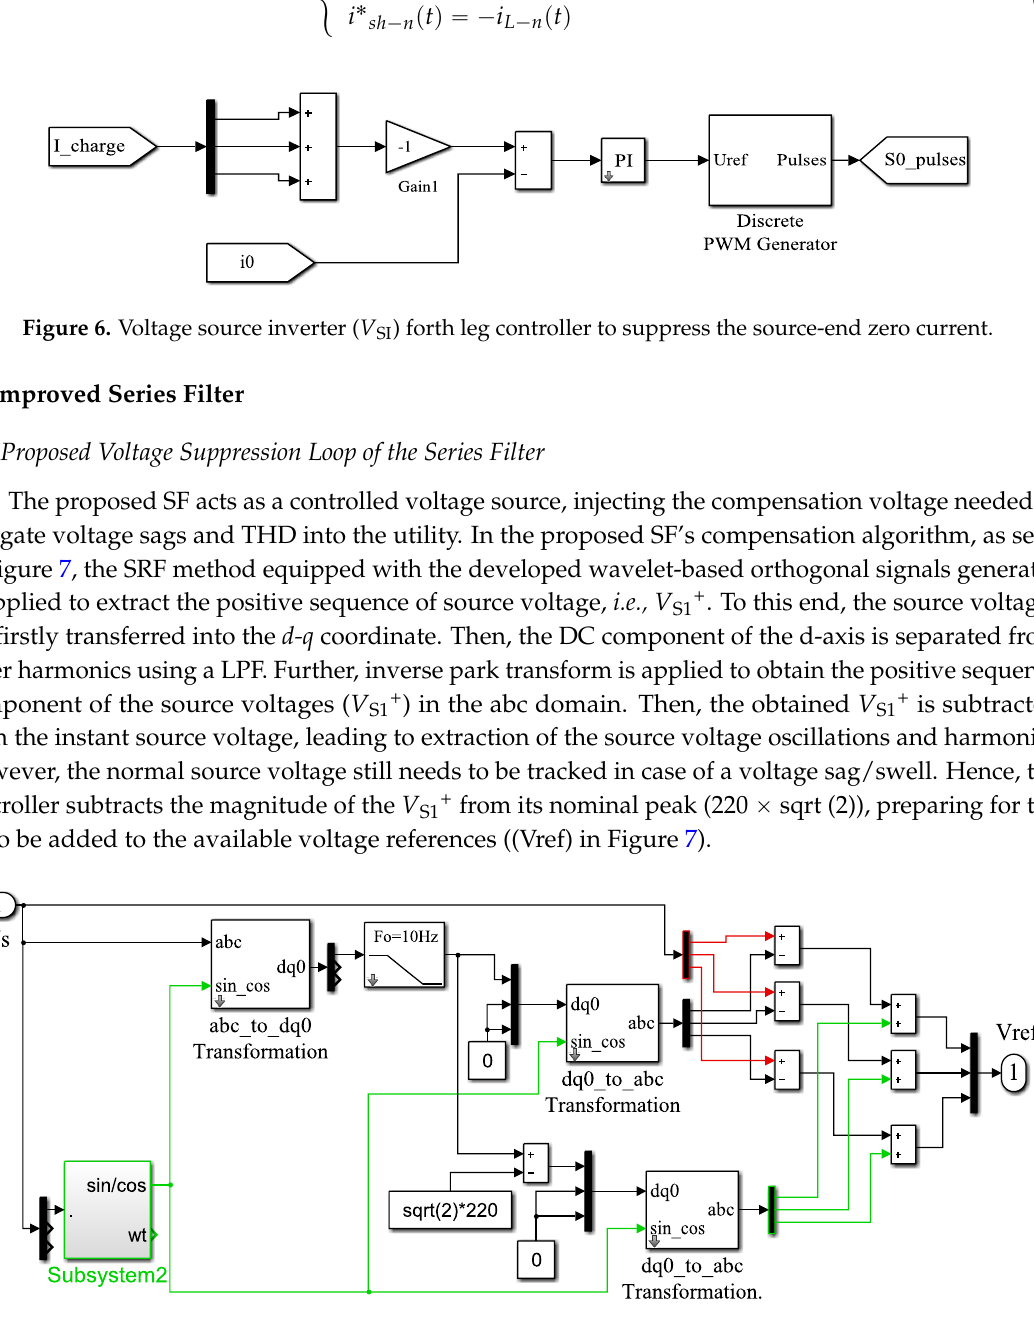
and a typical PLL.